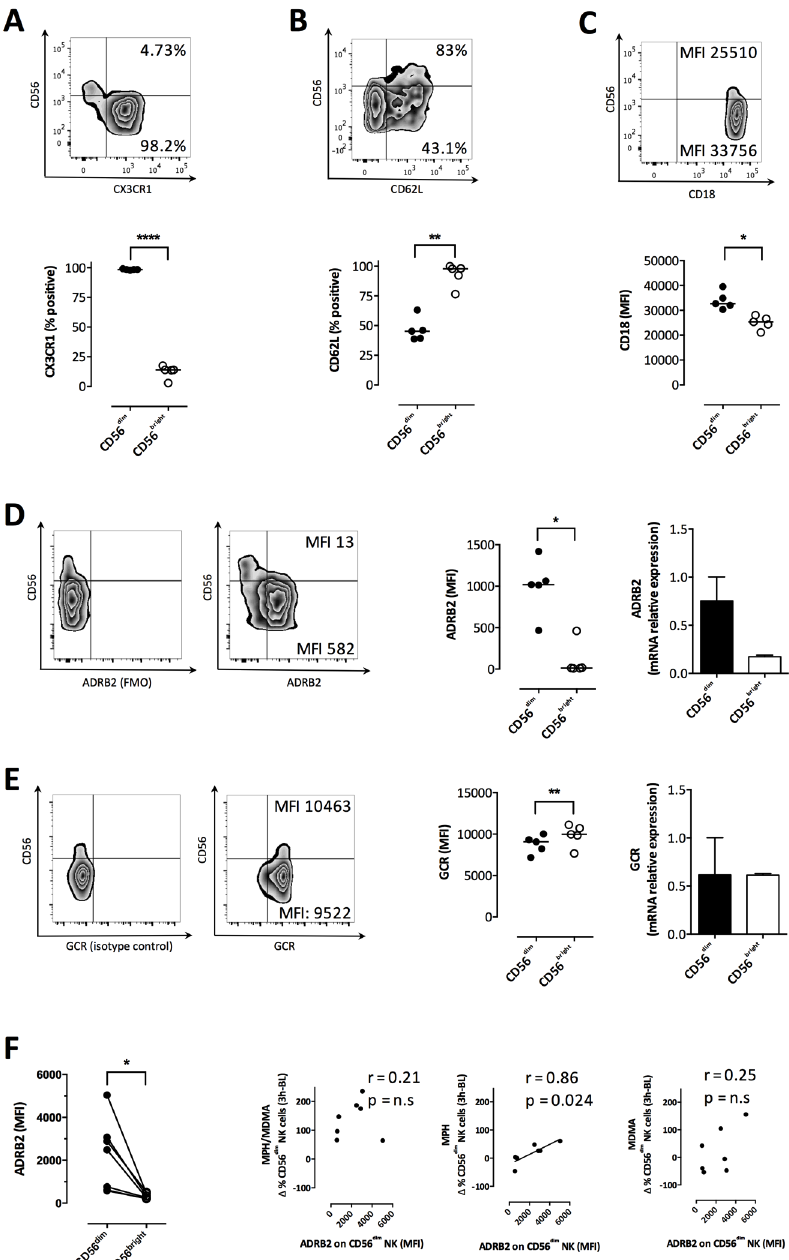
Fig 3. Preferential recruitment of CD56 dim NK cells depends on distinct hormone and migration receptor expression profiles. Expression of three receptors important in cell adhesion and migration were assessed by flow cytometry. (A-C) Example stainings gated on CD3 - CD56 + lymphocytes are shown for CX3CR1 (A), CD62L (B) and CD18 (C). The frequency (A, B) or MFI (C) of receptor expression on CD56 bright and CD56 dim is indicated (upper panels). Data on freshly derived PBMCs from five healthy, unstressed donors are summarized (A-C lower panels). (D, E) Expression of the epinephrine receptor (ADRB2) (D) and the glucocorticoid receptor (GCR) (E) were assessed on CD3 - CD56 + lymphocytes by flow cytometry. Isotype control stainings for ADRB2 and GCR are shown, followed by an example staining (left panels). The MFI of the two subsets is indicated for CD56 bright (upper right corner) and CD56 dim NK cell subsets (lower right corner). Flow cytometric data of the aforementioned five donors is summarized for CD56 bright and CD56 dim NK cells (middle panels). Differential ADRB2 and GCR expression on the two NK cell subsets were also confirmed on mRNA level by measuring relative hormone receptor expression on sorted CD56 dim (n = 3) and CD56 bright NK cells (n = 2) by qPCR (right panels). (F) Differential expression of ADRB2 on CD56 bright